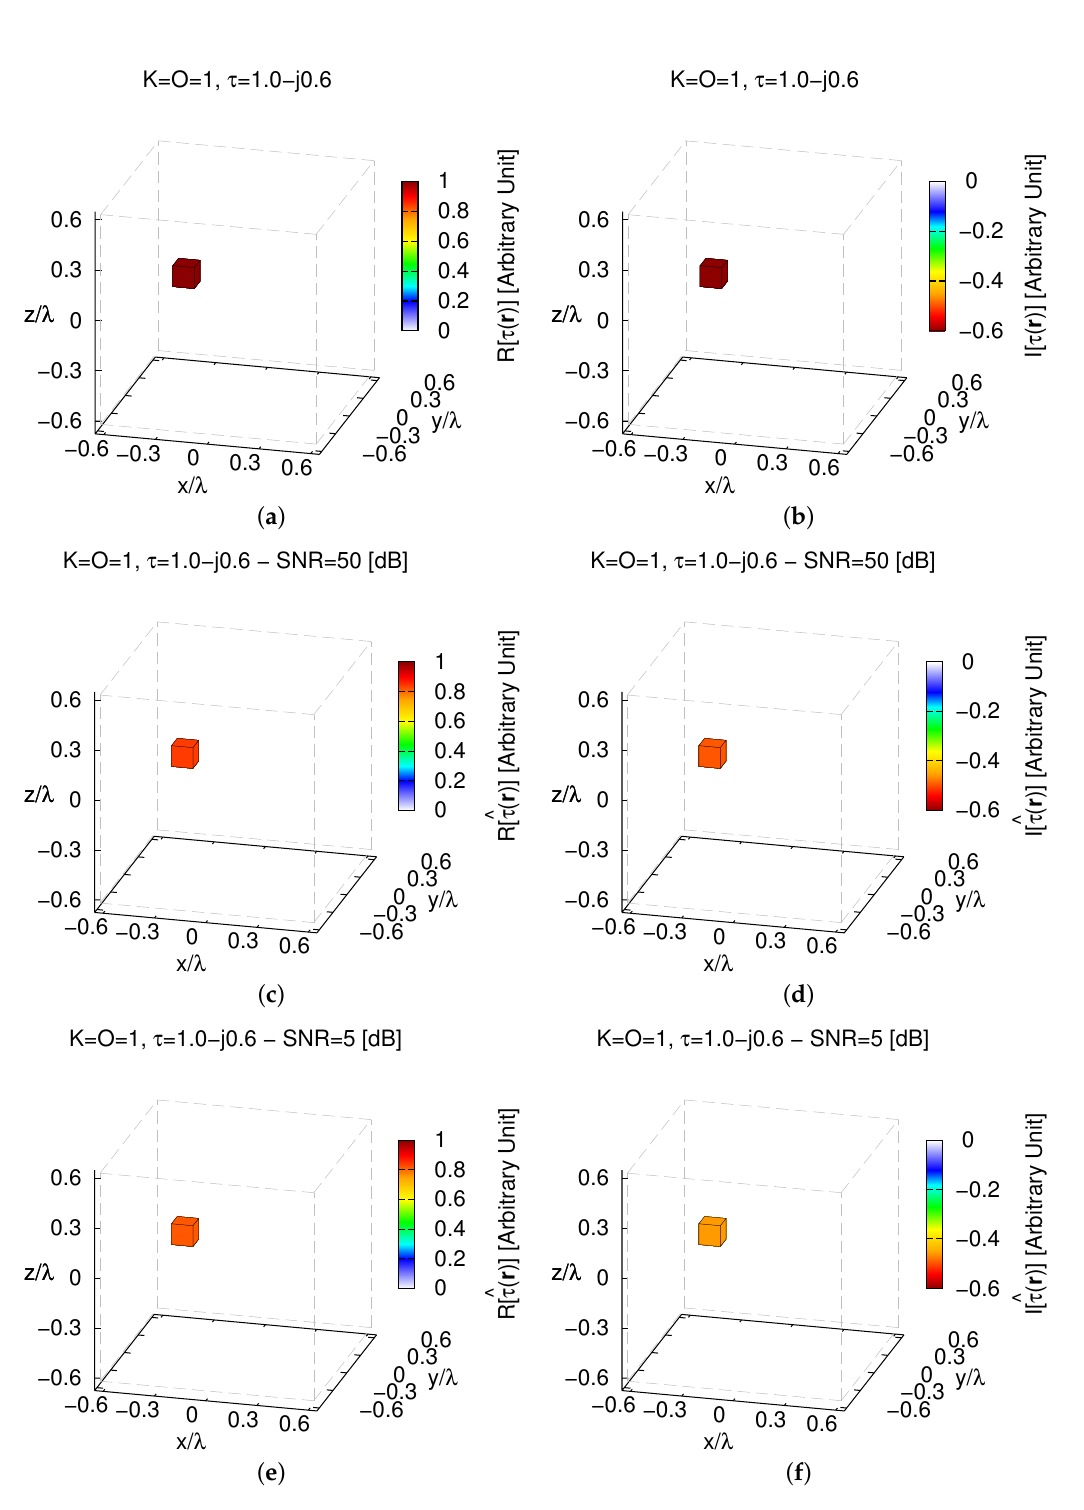
Figure 6. Numerical Assessment ( K = 1, O = 1, τ = 1.0 − 0.6 j )—Real ( a , c , e ) and imaginary parts ( b , d , f ) of the ( a , b ) actual contrast function and of the ( b – f ) MT-BCS reconstructed profiles when processing the scattering data with ( c , d ) SNR = 50 [dB] ( (cid:98) τ = 0.84 − 0.49 j ), ( e , f ) SNR = 5 [dB] ( (cid:98) τ = 0.81 − 0.45 j